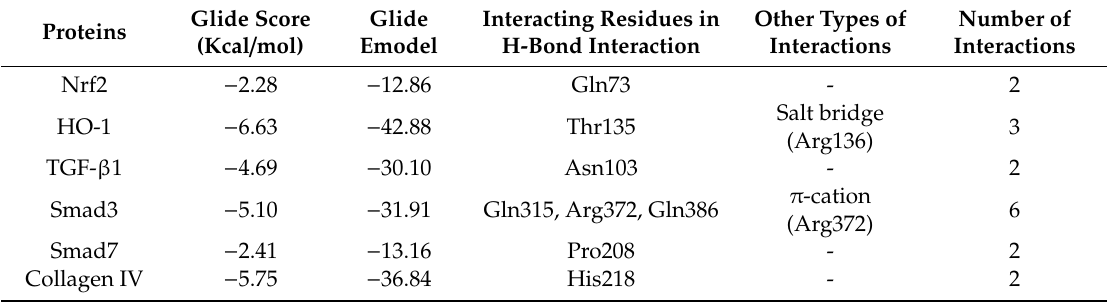
Table 1. Glide score, emodel value and interacting amino acid residues of di ff erent proteins in molecular docking analysis with